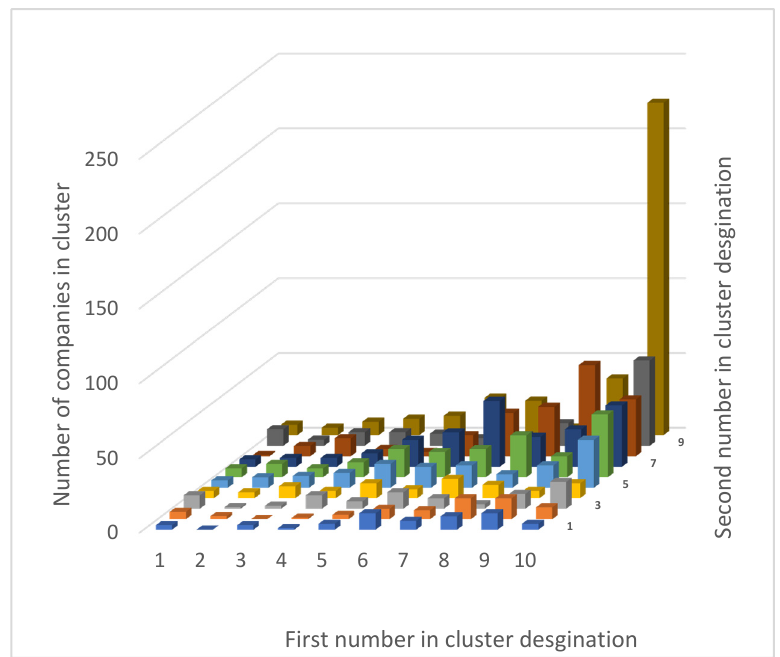
Table 7 . Number of companies in individual clusters for the year 2018